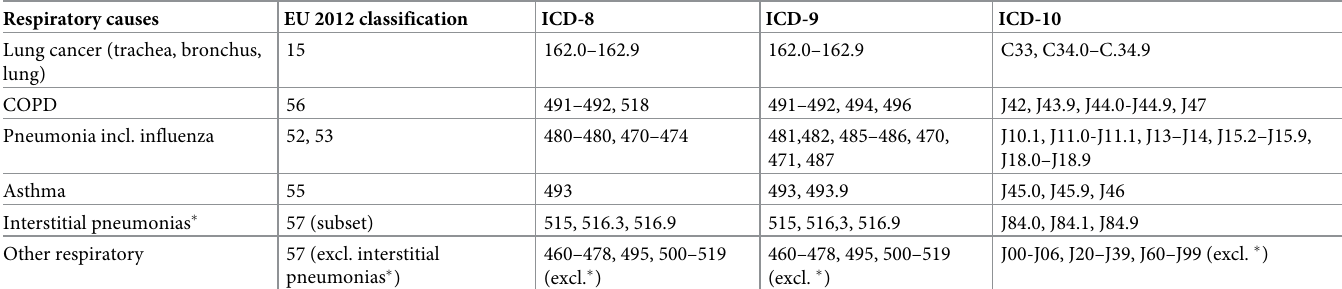
Table 2. Classification of underlying causes of